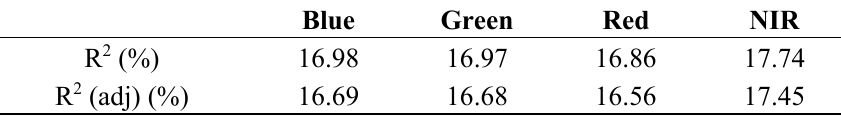
Table 6. Regression comparison (night